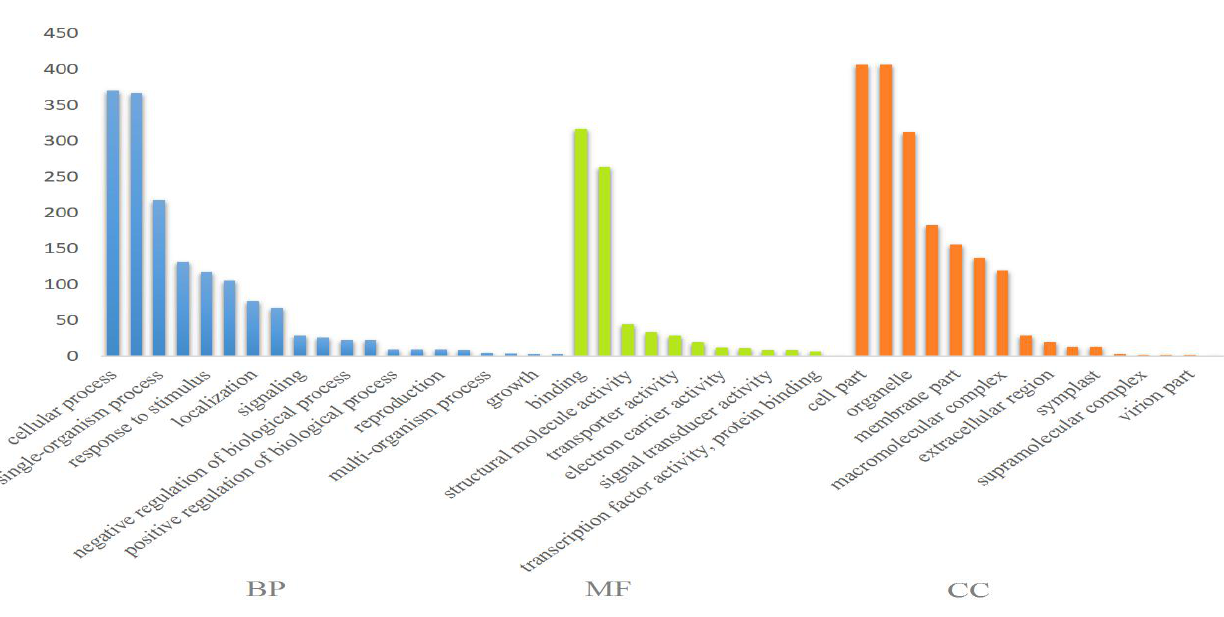
Figure 5. Distribution of GO terms of unigene sequences containing SSR in three main groups: biological process, cellular component, and molecular